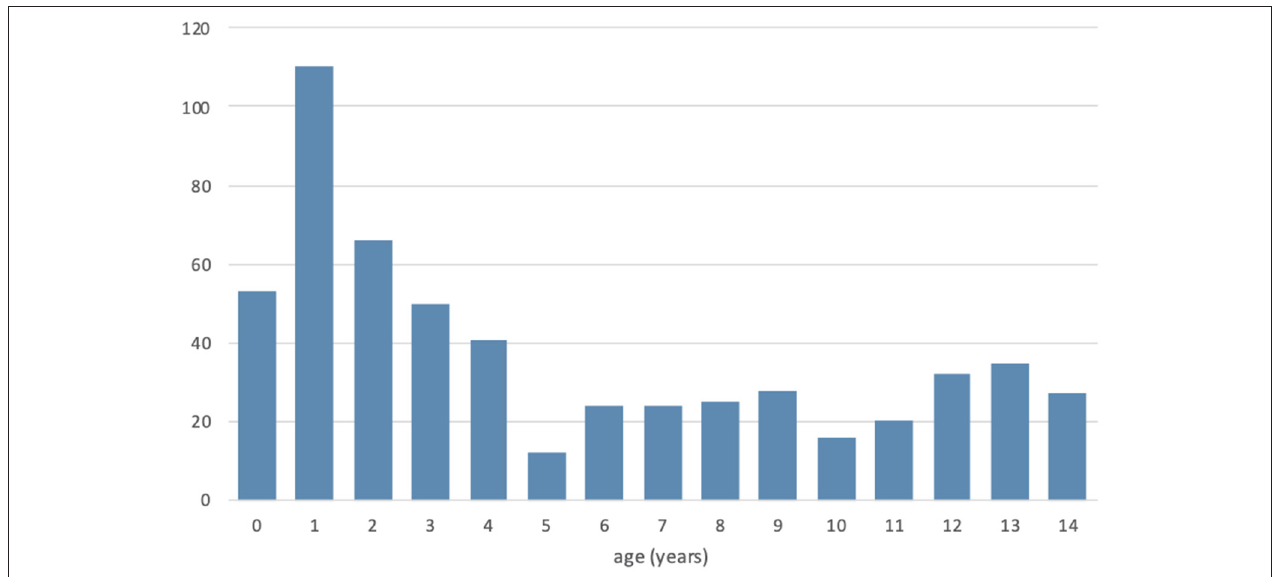
FIGURE 1 | Age distribution of pediatric surgical admissions in Mutoyi Hospital, Burundi